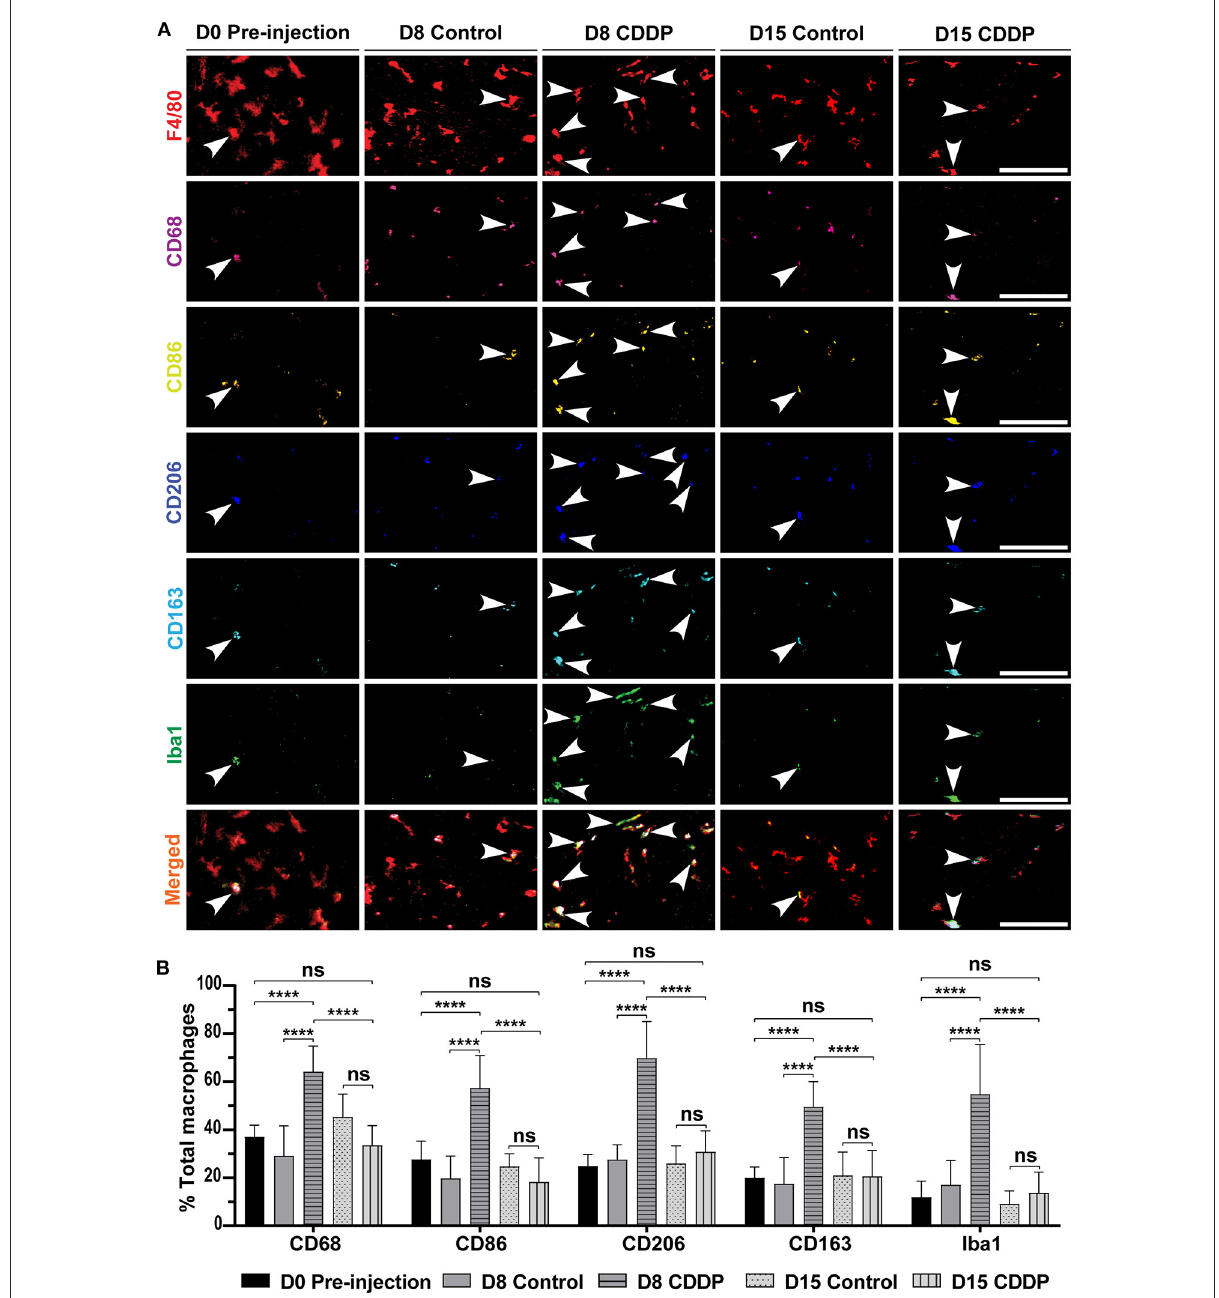
FIGURE4 Cisplatin increases the expression of M1, M2, and Iba1 markers in the auditory nerve. (A) Macrophage marker expression in different groups. On day 8 post-cisplatin injection, there was a marked increase in the expression of M1 markers (CD68 and CD86), M2 markers (CD206 and CD163), and Iba1. This increased expression was temporary and showed recovery on day 15. This increased expression suggested a temporary auditory nerve inflammation. There was no difference between the expressed markers in the control group. (B) Statistical analysis of the ratio of each marker expression in F4/80 + macrophages. In all the markers, there was significant increase in the ratio of expression on day 8 in cisplatin-injected mice ( n = 10) compared to that of the day 8 control ( n = 8), day 0 pre-injection ( n = 6), and day 15 cisplatin-injected mice ( n = 8). **** P < 0.0001, ns, not significant by two-way ANOVA with Bonferroni post hoc test. The error bars represent standard deviation from the